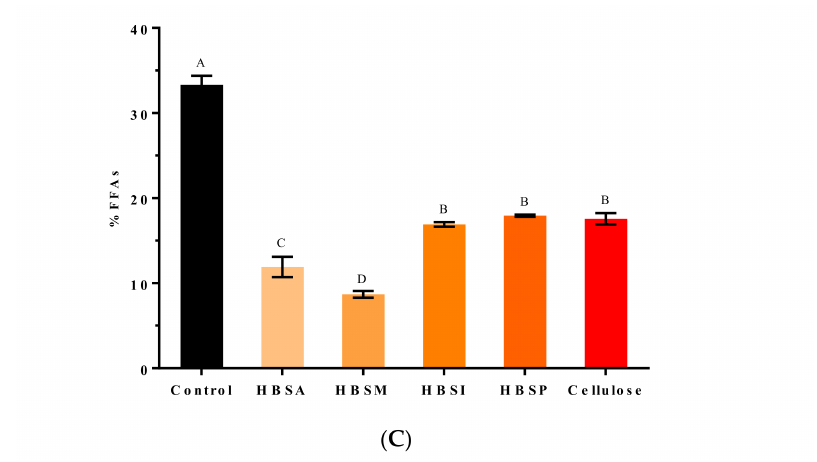
Figure 4. Effects of HBSA, HBSM, HBSI, and HBSP on microstructures ( A ), the estimated area of lipid droplets ( B ), and FFAs release rates ( C ) of lipid emulsion during lipolysis in vitro. Images were acquired at the magnification of 20.0 × at room temperature. Values with different letters were significantly different ( p < 0.05). Lowercase letters indicated differences among the EA of droplets within the same digestion phase. Capital letters indicated differences among FFAs release